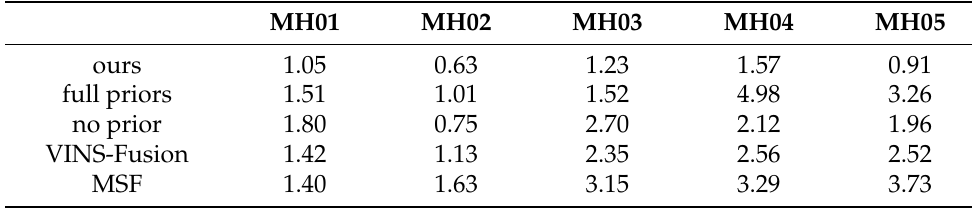
Table 2. Median rotational errors (deg) tested on EuRoC datasets.